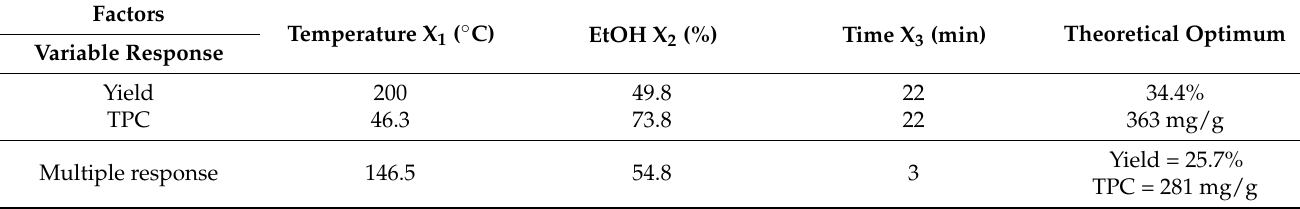
Table 8. Theoretical values of independent variable to maximize the response variables provided by the model.